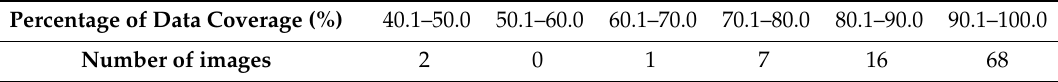
Table 3. Percentage of LST data within the study area available from the selected Landsat 8